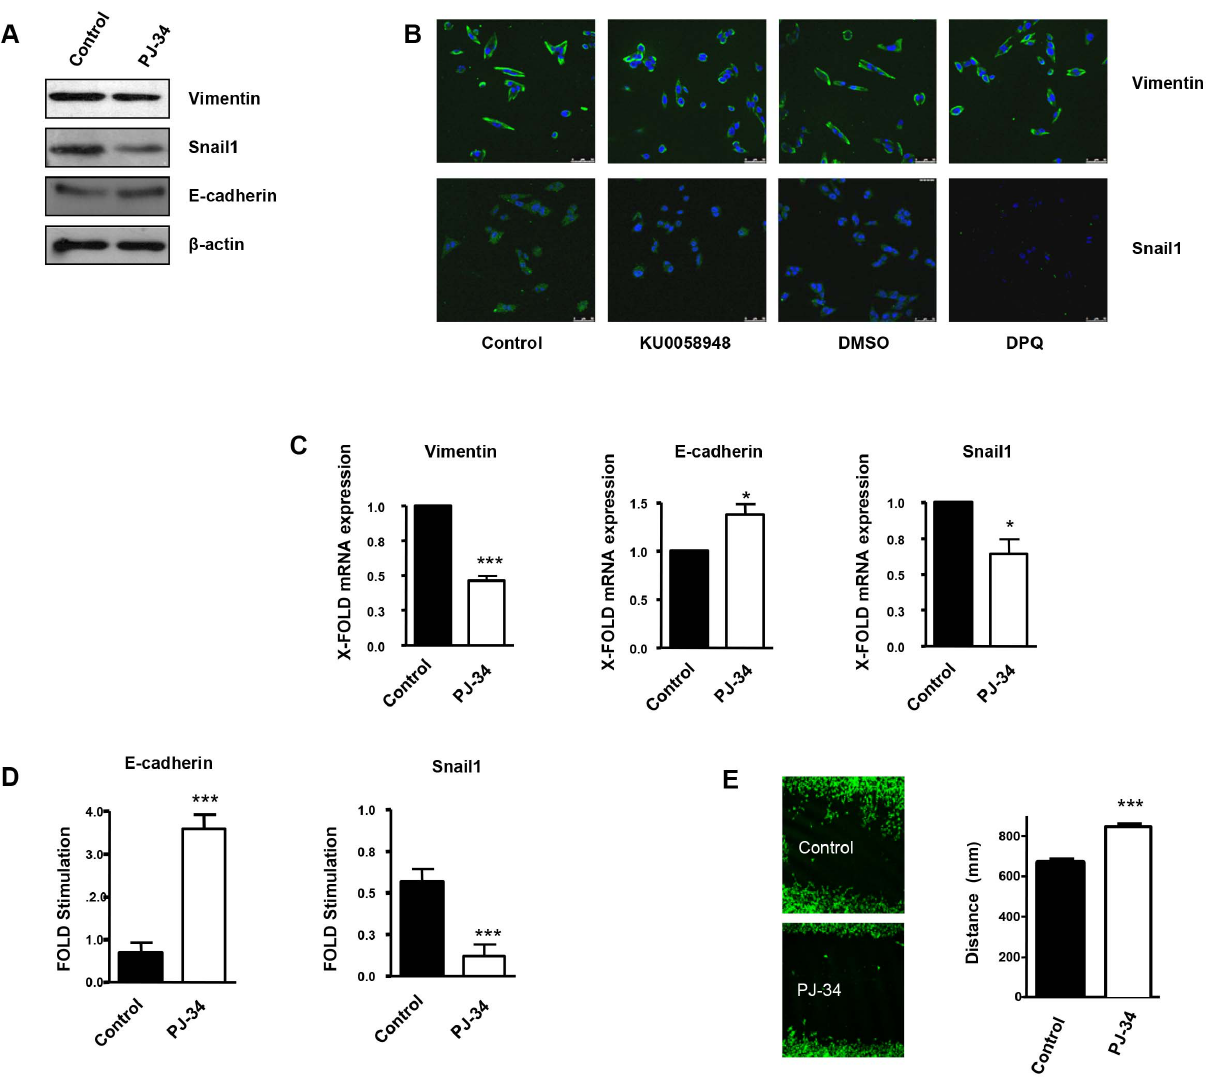
Figure 3. PARP inhibition inhibits the acquisition of an EMT phenotype in malignant melanoma cells. Human melanoma G361 cells and murine B16- F10 melanoma cells (Figure S3) were used for these experiments. Cells were treated with either DPQ (40 m M), PJ-34 (10 m M) or KU0058948 (100 nM) for 22 hours. IF, western blot or qPCR assays were performed to evaluate the effects of PARP inhibition on EMT markers. PARP inhibition reduced the expression of vimentin and Snail1 and up-regulated E-cadherin in human melanoma cells as determined by immunoblotting ( A ), indirect immunofluorescence ( B ), and mRNA levels ( C ). (* P , 0.05, *** P , 0.001, PARP Inhibitor groups versus the control). b -actin was used as an internal control for protein loading. ( D ) Snail1 and E-cadherin promoter activity are regulated by PARP inhibitors. Luciferase activity was